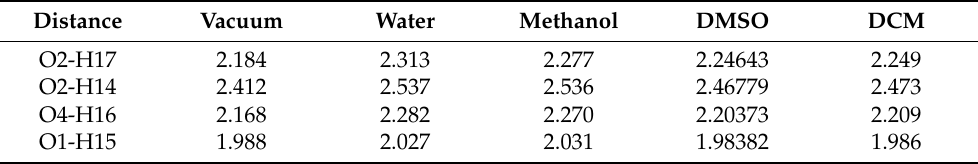
Table 2. Summary of distances of the hydrogen bonding from geometric optimized structure in different solvents. Distance Vacuum Water Methanol DMSO DCM